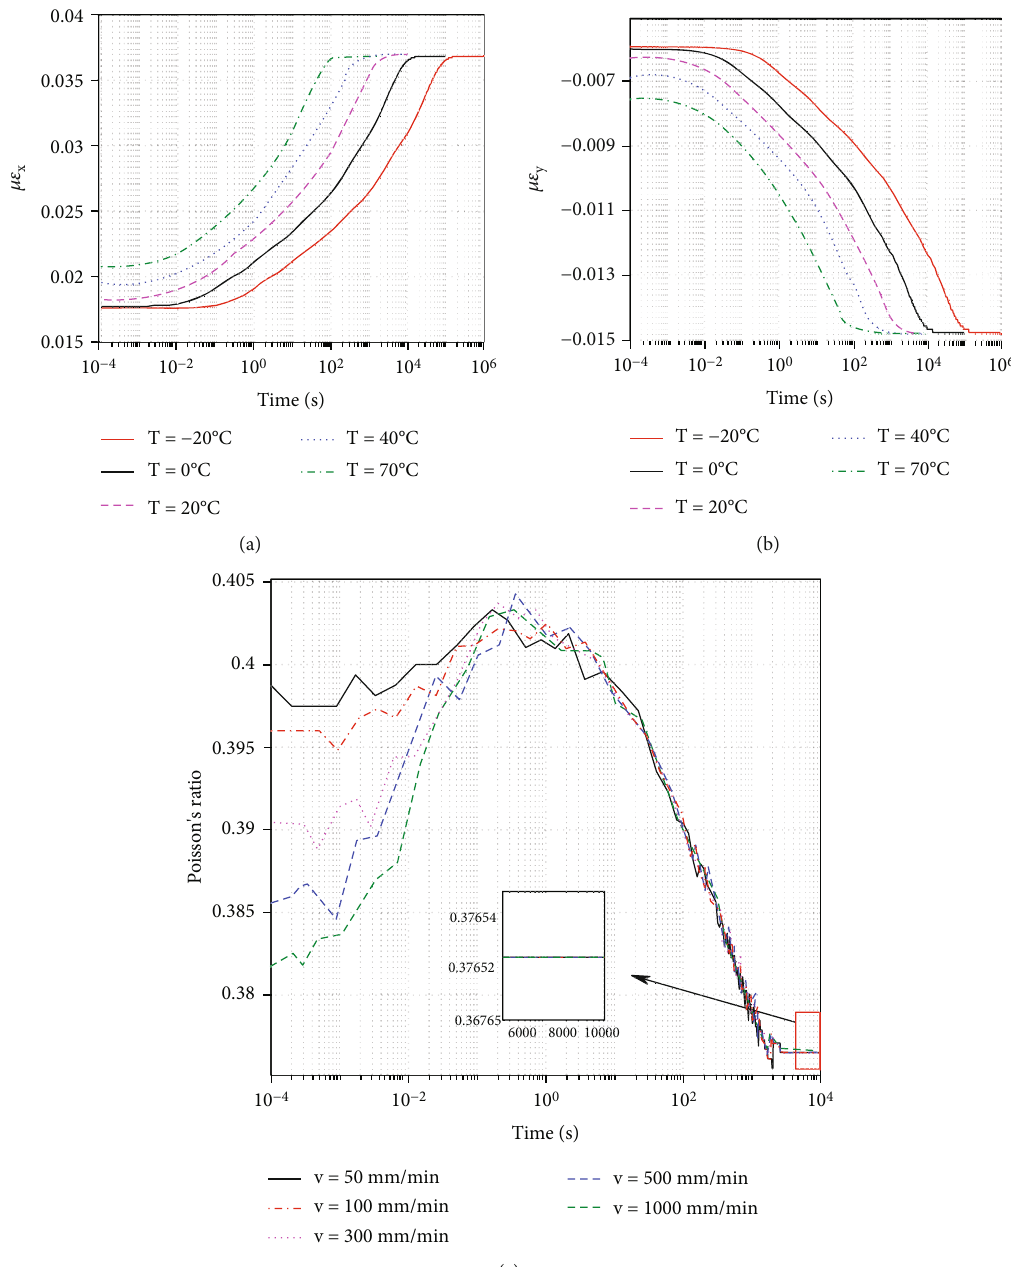
Figure 15: The curves of the (a) longitudinal strain, (b) transverse strain, and (c) Poisson ’ s ratio versus time under di ff erent loading rates when cohesive strength equals to